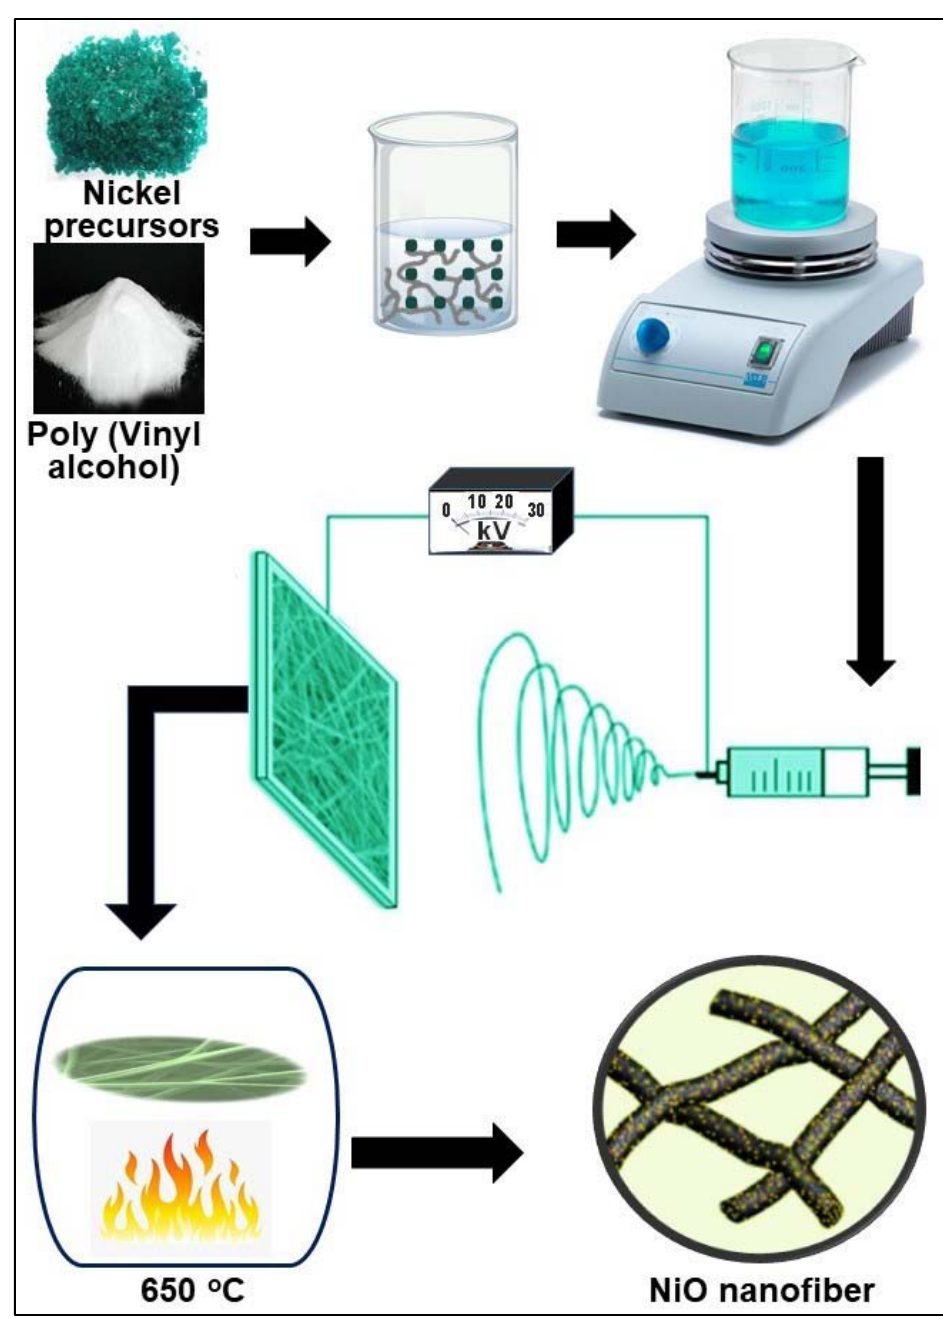
Figure 1. Schematic illustration of NiO nanofibers synthesis using electrospinning. SEM images of the PVA/NiAc nanofibers electrospun from 0.2 mol/L of NiAc, before